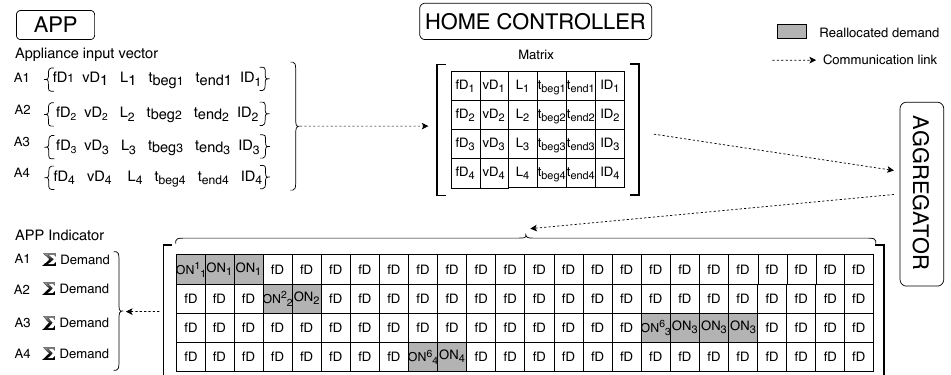
Figure 4. Message exchange among the system’s players.